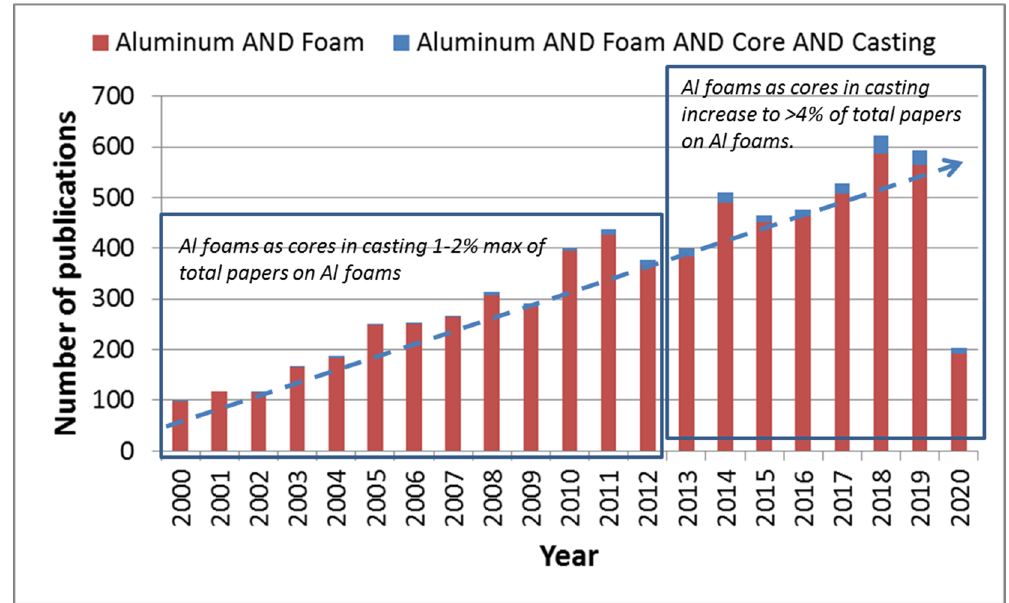
Figure 1. Publications on aluminum foams vs aluminum foams in casting in the last 20 years (data from Scopus).